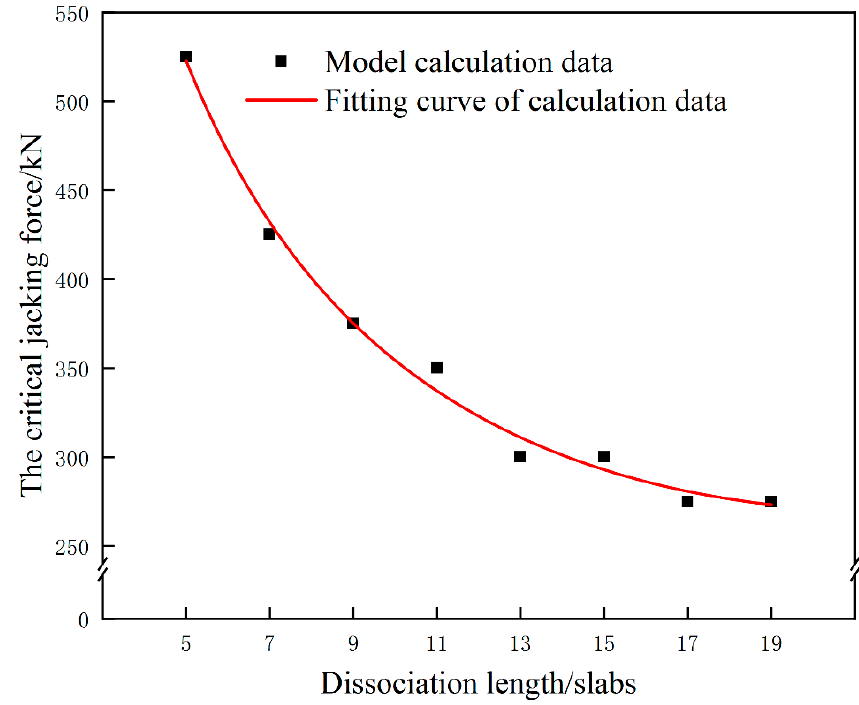
Figure 15. The critical jacking force corresponding to different dissociation lengths under multi-point jacking condition.